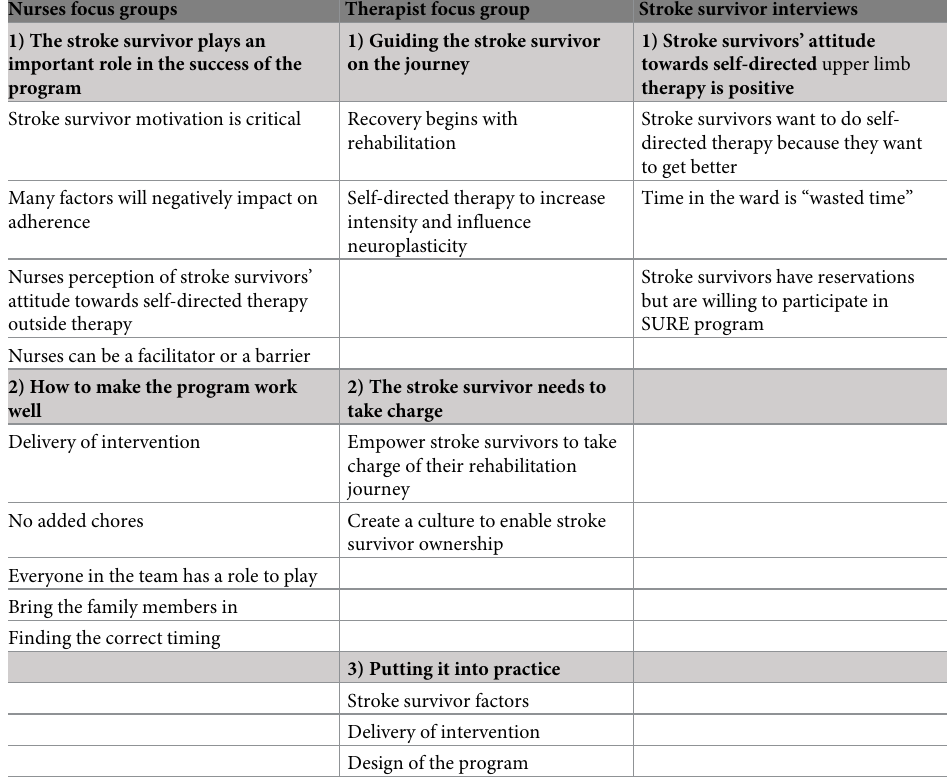
Table 4. Summary of the themes and subthemes from the nurse and therapist focus groups and from stroke par- ticipants